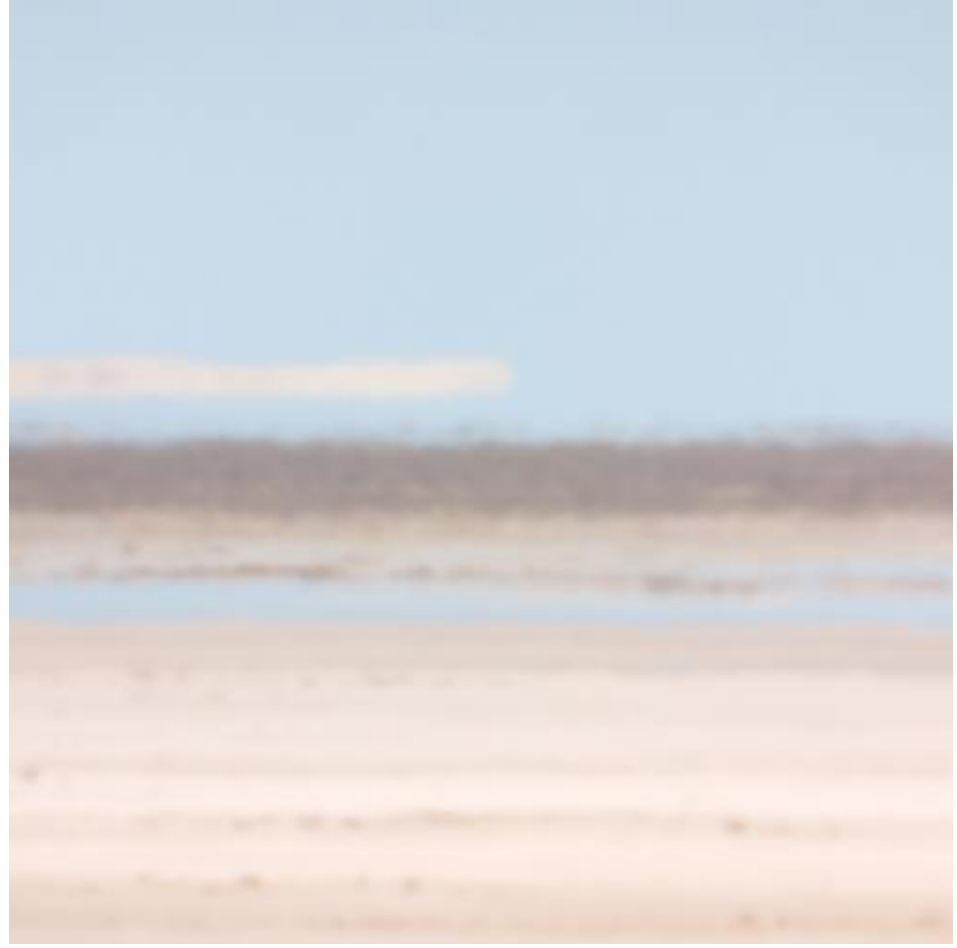
Trevor Paglen, Chemical and Biological Weapons Proving Ground/Dugway; UT/Distance approx. 42 miles; 11:17 a.m. , from the Limit Telephotography series, 2006. C-print, 40 x 40 in. Copyright Trevor Paglen, courtesy the artist and Metro Pictures, New York; Altman Siegel, San